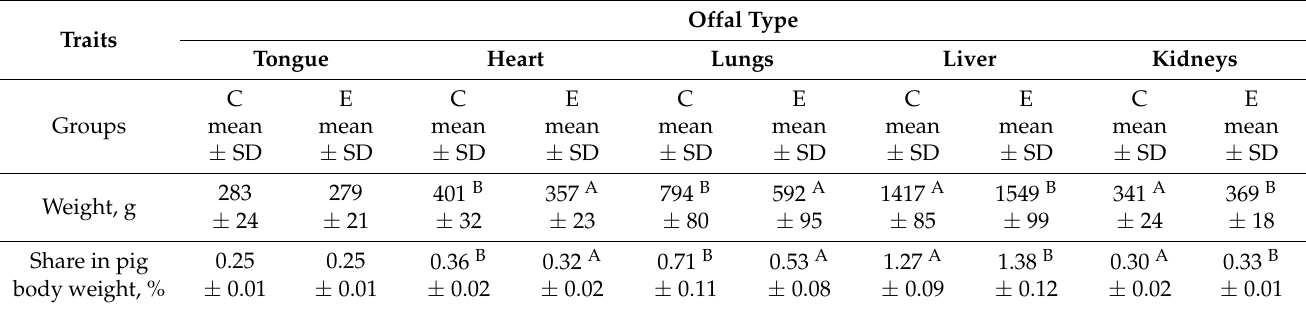
Table 4. Weight and share in pig body weight of the pigs.